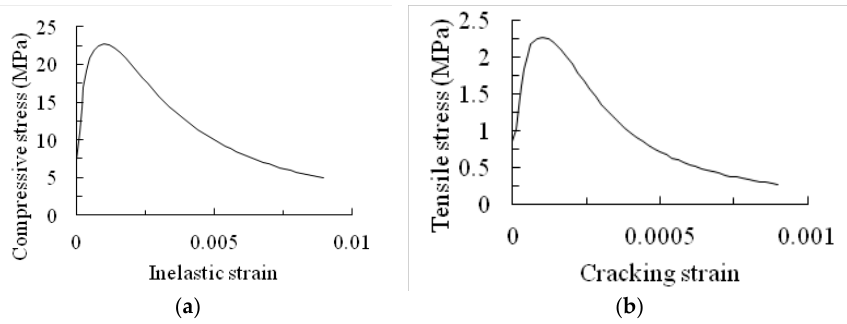
Figure 9. Input curves used in ABAQUS for: ( a ) compressive versus inelastic strain; ( b ) tensile stresses versus cracking strain.